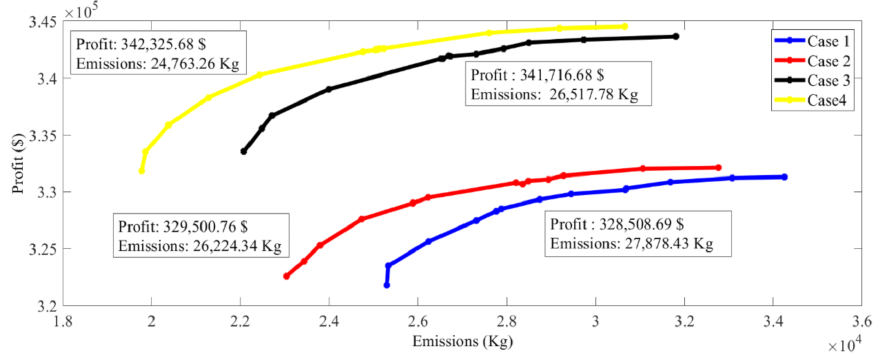
Figure 12. Pareto-front of all the non-dominated solutions obtained for different